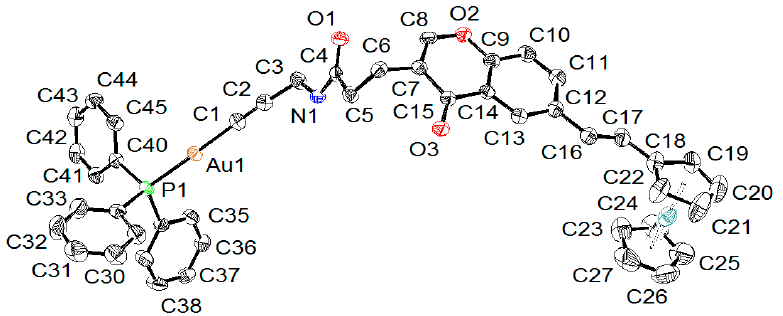
Figure 1. ORTEP drawing of 5 at 50% probability ellipsoids with hydrogen atoms and solvent molecules omitted for clarity.